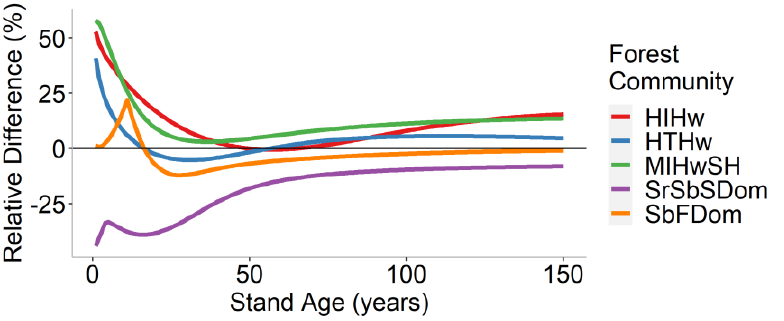
Figure 10. Relative difference (CBM–SP/PSP ∗ 100) in stand-level carbon estimation between CBM and PSP methods for each forest community, over stand age.